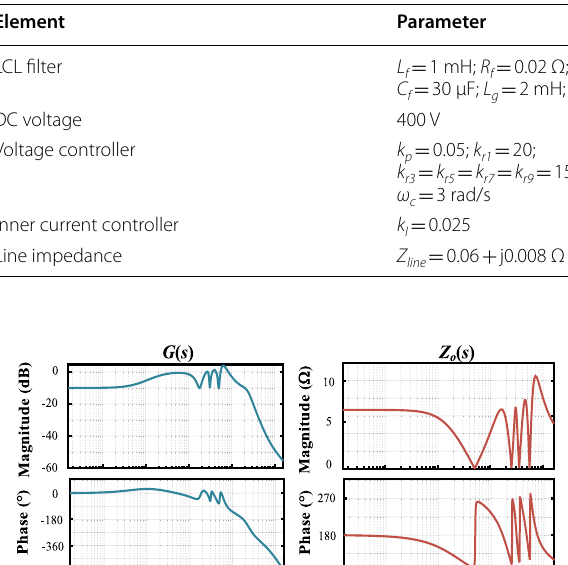
Fig. 6 Equivalent circuit of a DG. ( a ) Equivalent circuit at the positive-sequence fundamental frequency ( b ) Equivalent circuit at the negative-sequence fundamental and harmonic frequencies Fig. 7 Bode diagram of G (s) and Z o (s) of the